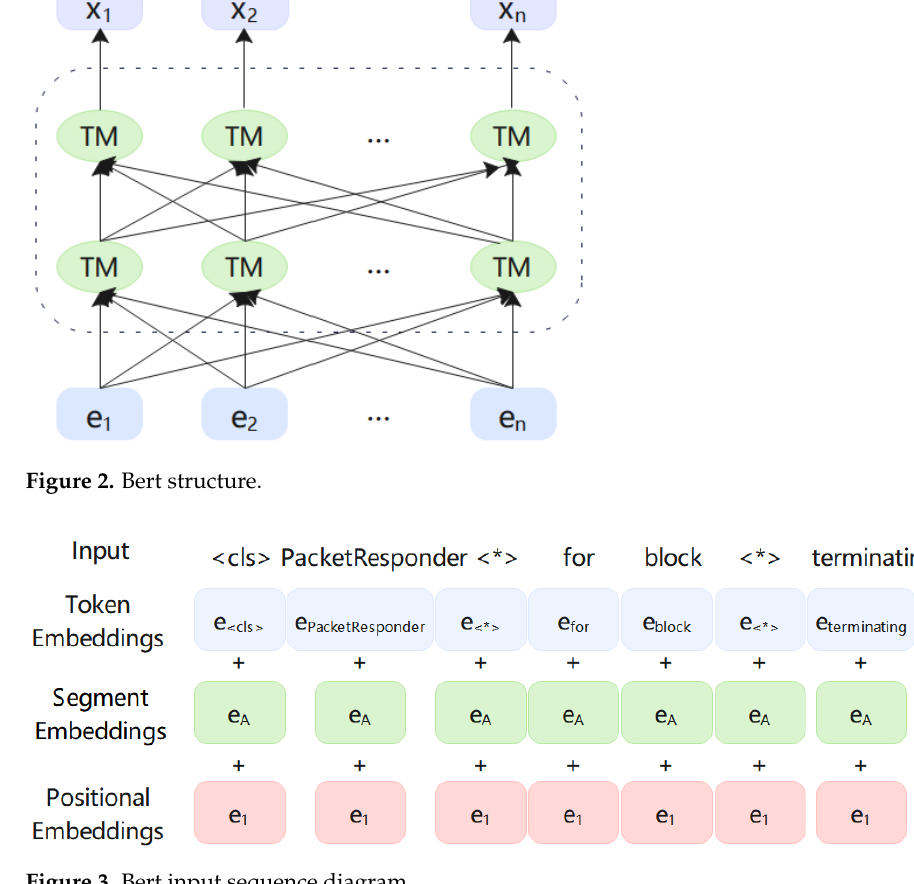
Figure 3. Bert input sequence